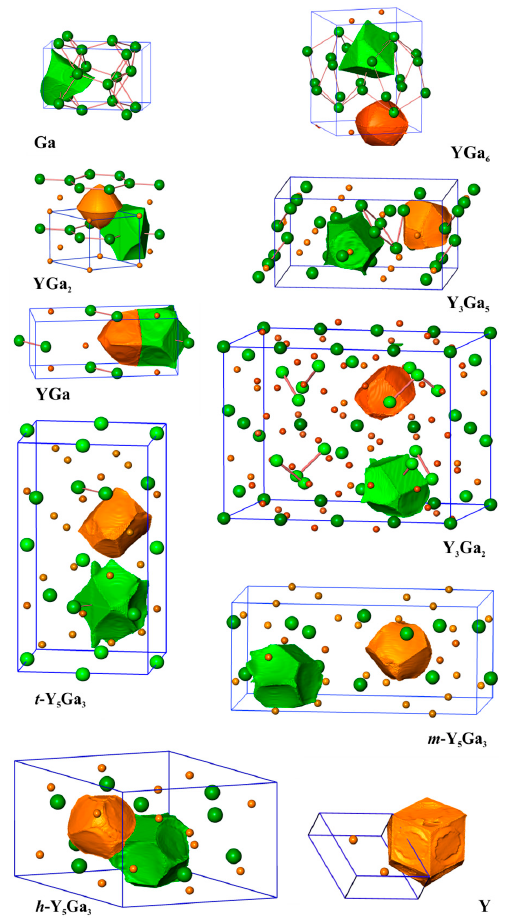
Figure 2. The shapes of selected Y and Ga atoms in the yttrium compounds with gallium. All panels are shown in the same scale. Crystals 2018 , 8 , x FOR PEER REVIEW